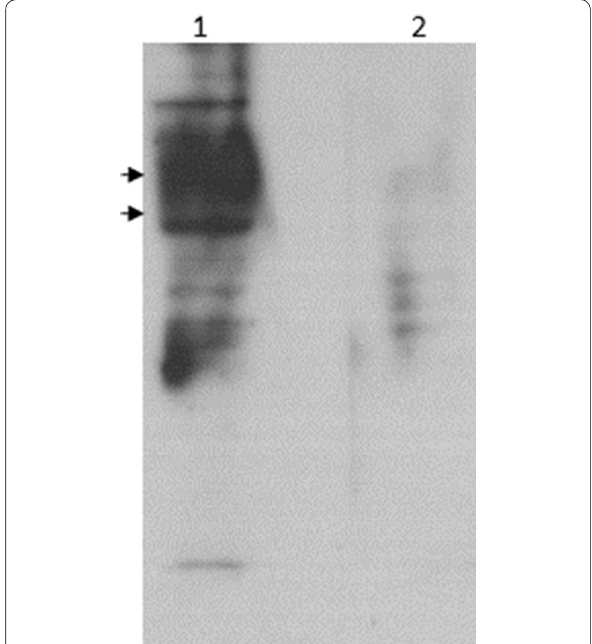
Fig. 1 Proteins contained in 20 μg of a NPCs lysate were separated in a 12% polyacrylamide gel and transferred onto PVDF membrane. Individual strips were probed with lane 1: immunized serum 2 and lane 2: the pre immune serum at a 1:1000 dilution in blocking buffer. A HRP-conjugated anti mouse IgG antibody (Cell Signaling, 7076) diluted 1:2000 in blocking buffer, served as secondary antibody. Blot was visualized with the ECL reagent on a autoradiography film. Arrows indicate the positions of the 58 and 80 kDa molecular mass